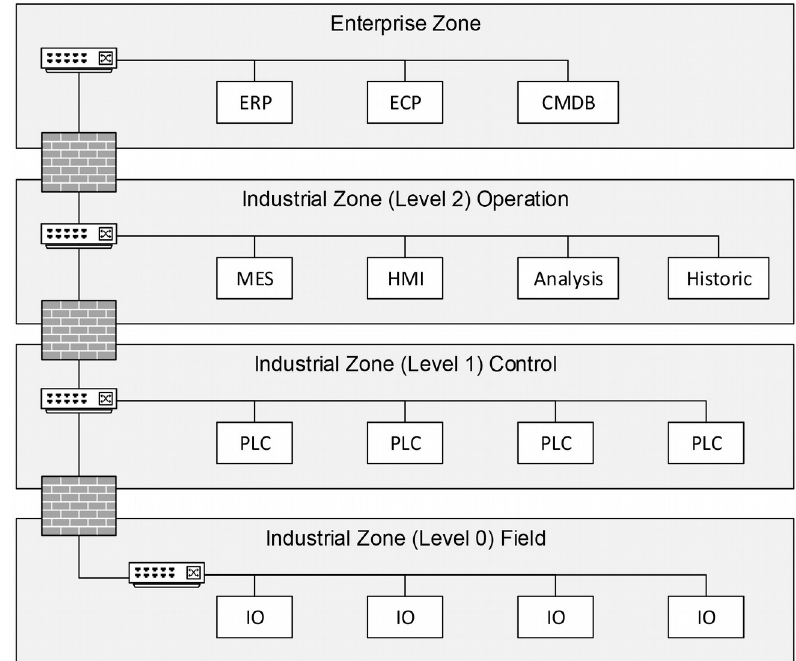
Figure 2. Zone segmentation of Enterprise & ICS (ISA/IEC